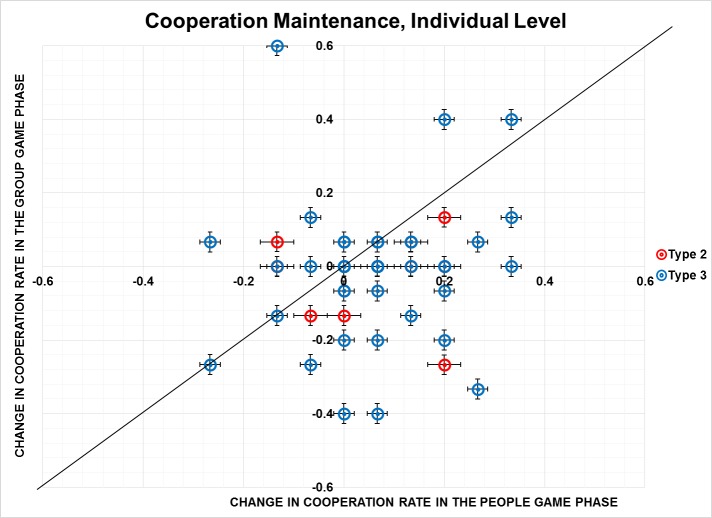
Cooperation Maintenance, Individual Level.The change in cooperation rate (from later to the earlier round of the game) for the Group Game phase (y-axis) as a function of change in cooperation in the People Game phase (x-axis) for Type 2 and Type 3 individuals. Type 2 are participants who cooperated more in People Game phase than in Group Game phase; Type 3 are participants who cooperated less in People Game phase, than in Group Game phase. Each square is a participant of Type 2, each triangle—participant of Type 3. Error bars represent standard error (SE).